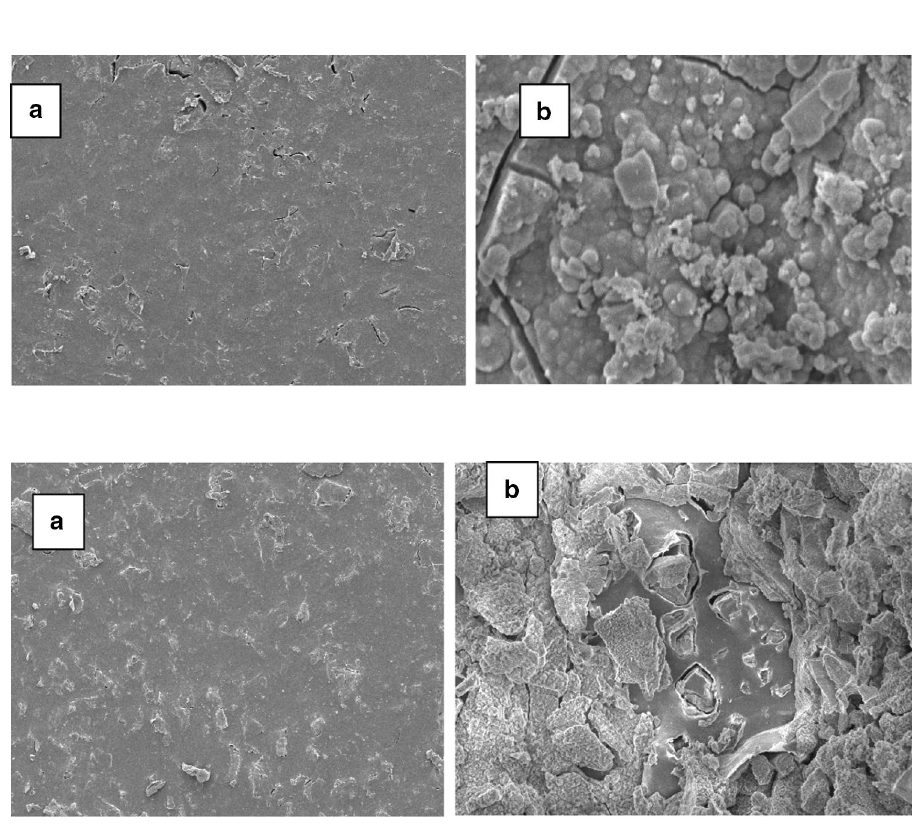
Fig. 8 FTIR of domestic waste water